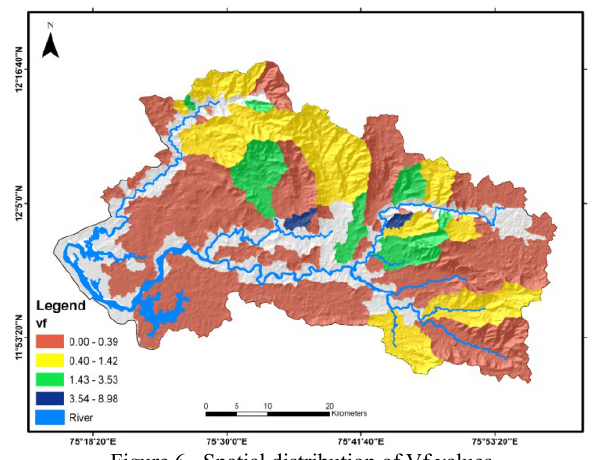
Figure 6. Spatial distribution of Vf